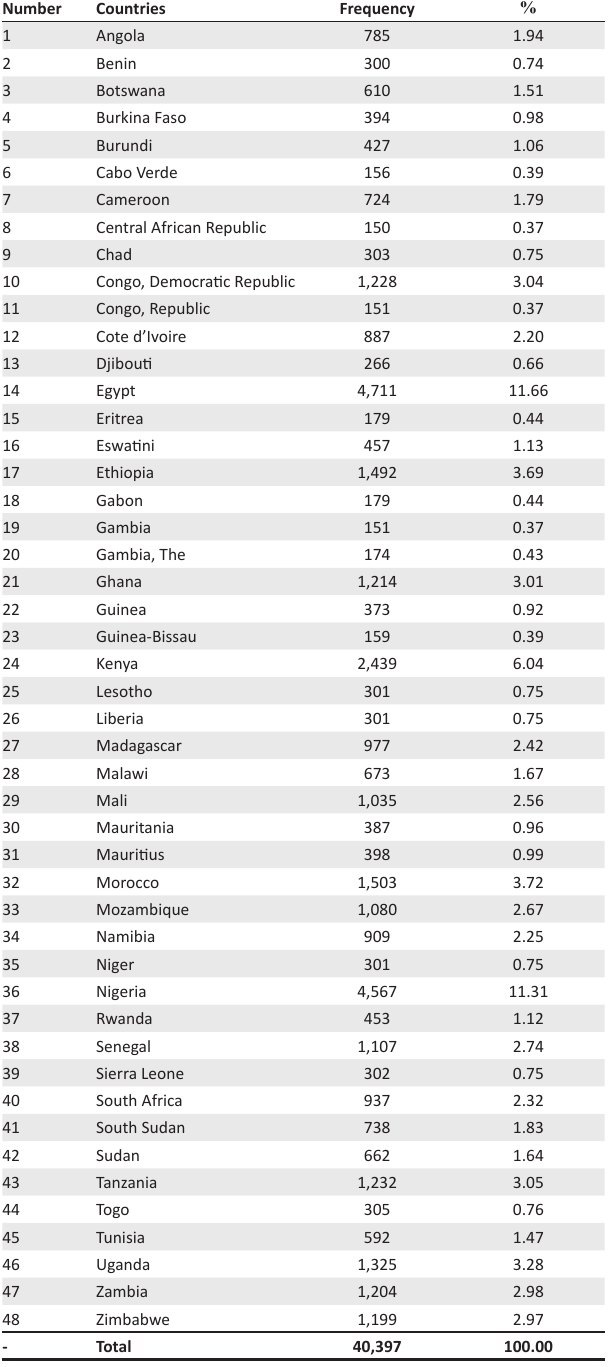
TABLE 1-A1: Descriptive statistics of countries included in the